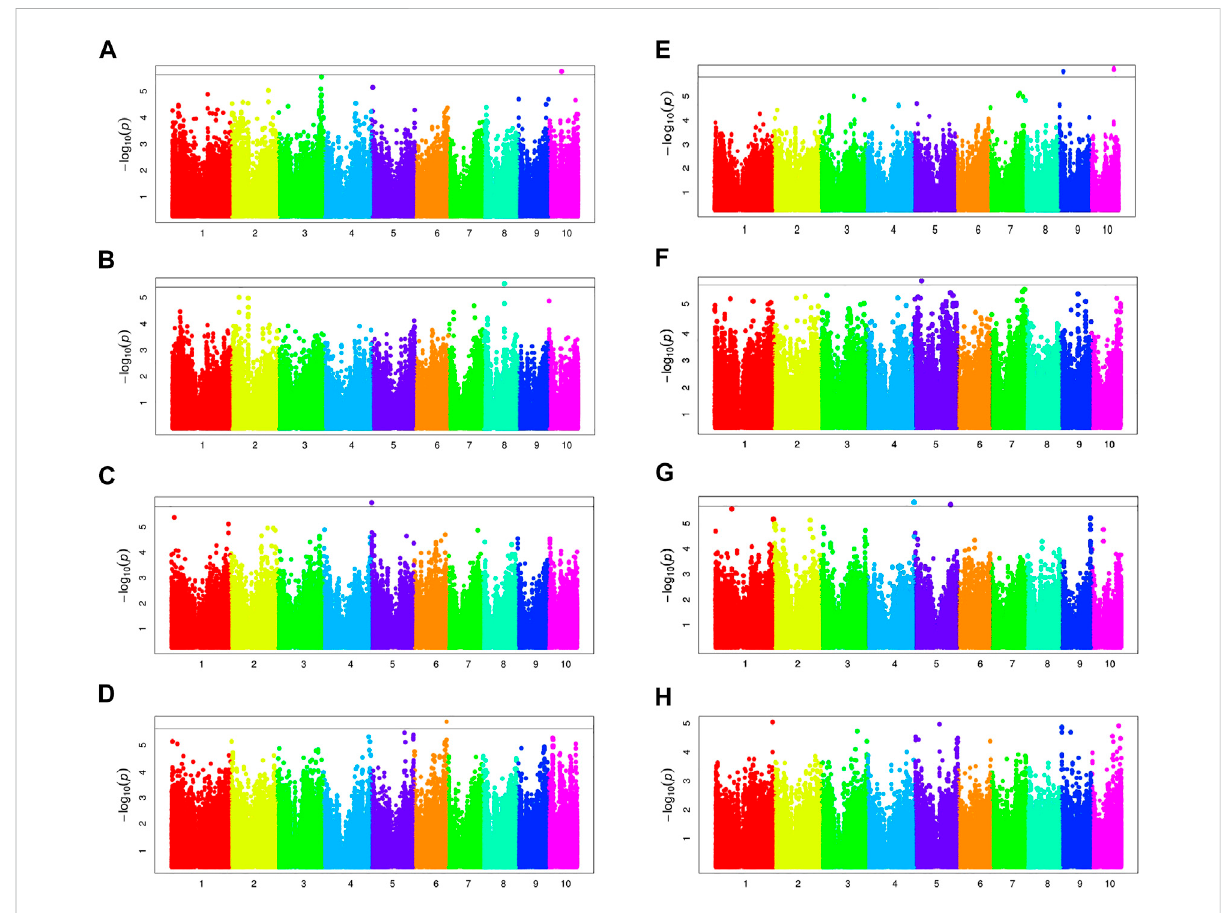
FIGURE 6 Manhattan plots of BRA and BRD by MLM. Manhattan plots for BRA-BLUP , 16LN-BRA , 16JL-BRA , 17LN-BRA , BRD-BLUP , 16LN-BRD , 16JL-BRD and 17LN-BRD are shown in (A) , (B) , (C) , (D) , (E) , (F) , (G) and (H) , respectively. The black lines show genome-wide signi fi cance at stringent thresholds of 1.84 × 10 − 6 .